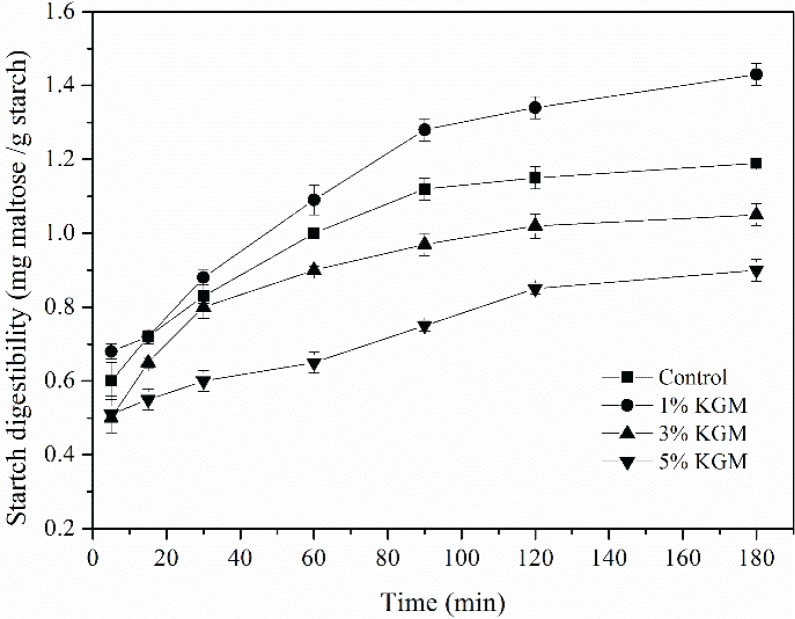
Digestibility of precooked wheat starch substituted with KGM of different concentrations (1 wt%, 3 wt%, and 5 wt%).